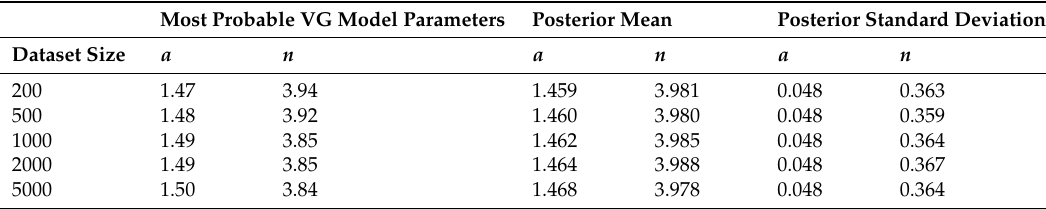
Table 2. Impact of dataset size on update results.